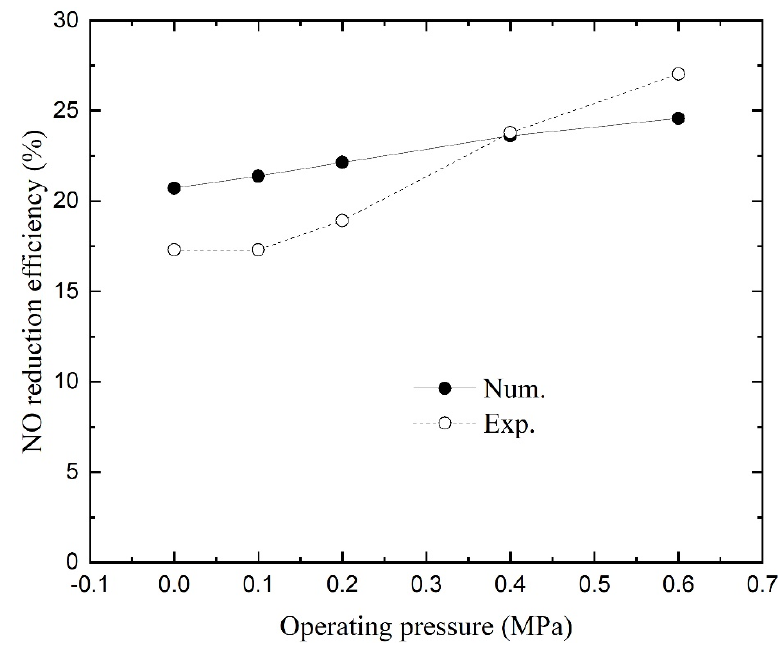
Figure 8. NO reduction efficiency as a function of operating pressure.